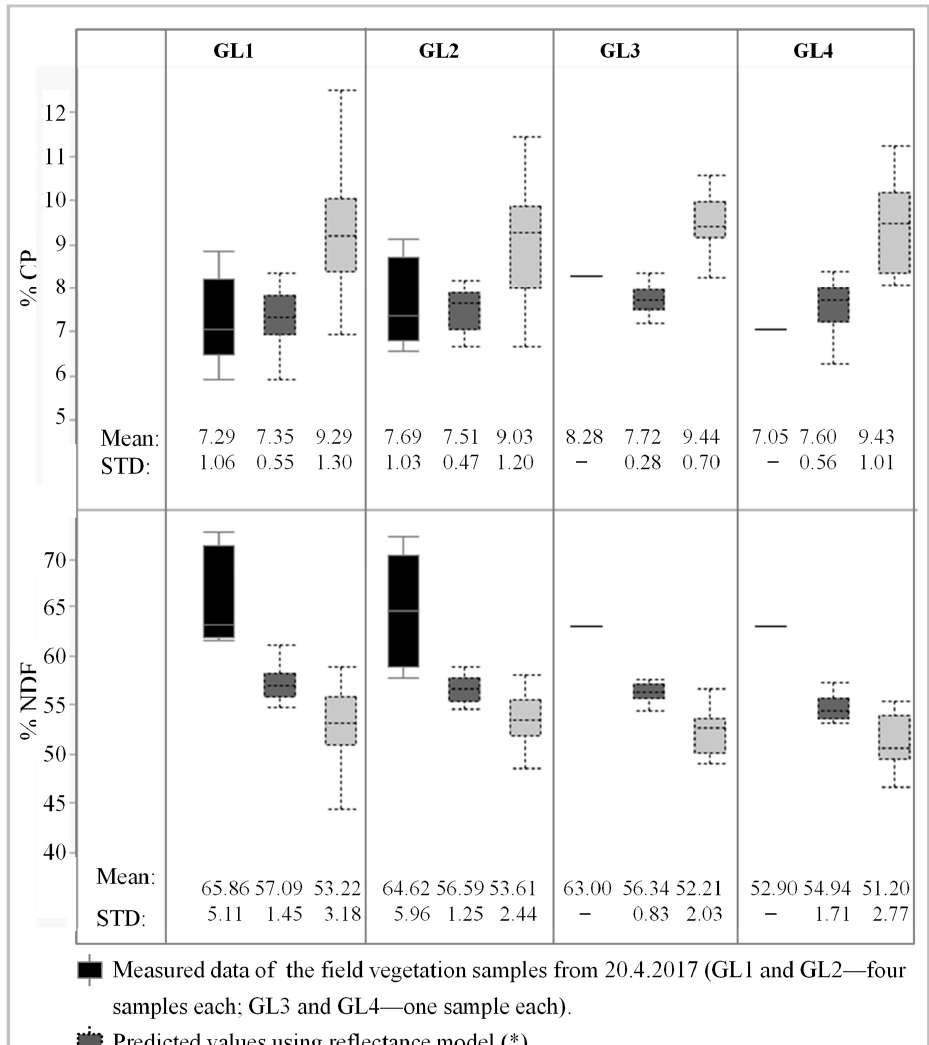
Figure 6. Distribution of the crude protein (%CP) and neutral detergent fiber (%NDF) contents obtained from field measurements (from 20 April 2017), and of the predicted values obtained by applying reflectance and FD models on a Sentinel-2 reflectance image (from 21 April 2017), for each plot. Table 5. Partial least-squares (PLS) regression results for reflectance-based (the best selected) and vegetation indices-based